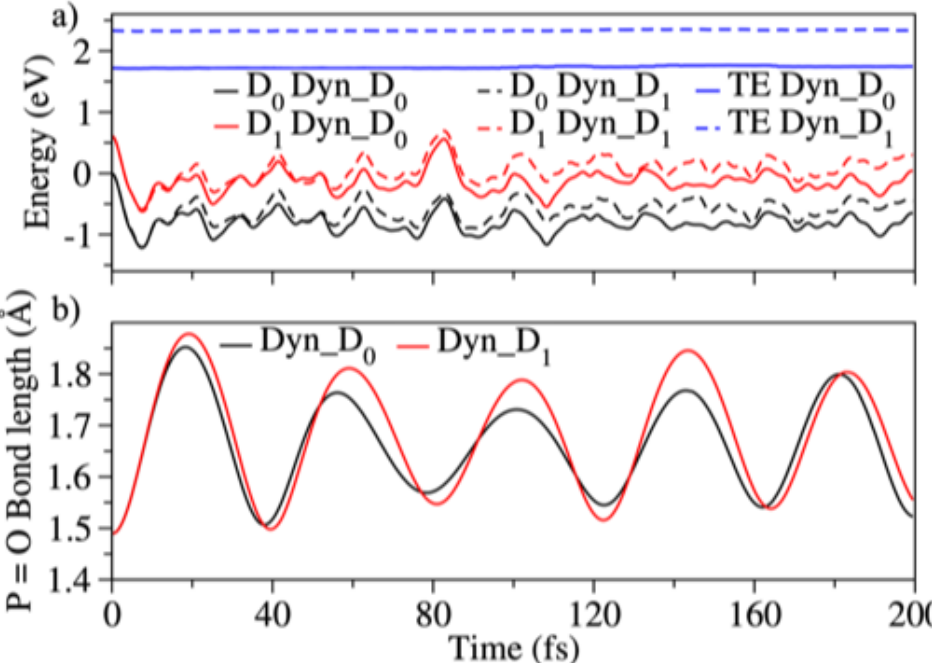
Figure 4. ( a ) Mean potential energies of D 0 , D 1 and the total energies (TE) plotted vs time for the dynamics of the populations starting on the electronic states D 0 (Dyn_D 0 ) and D 1 (Dyn_D 1 ). The energies were calculated on-the-fly using 2SA-CAS(13,9)/6-311G(d) level of theory. ( b ) Mean P=O bond lengths plotted vs time for the dynamics starting on D 0 or D 1